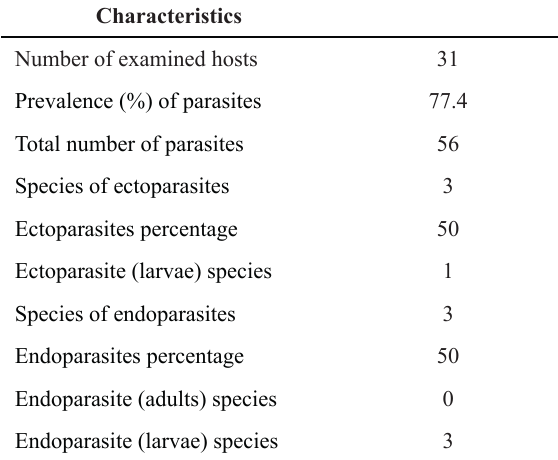
Component community of metazoan parasites of Hemibrycon surinamensis from the Matapi River, in Amapá State,